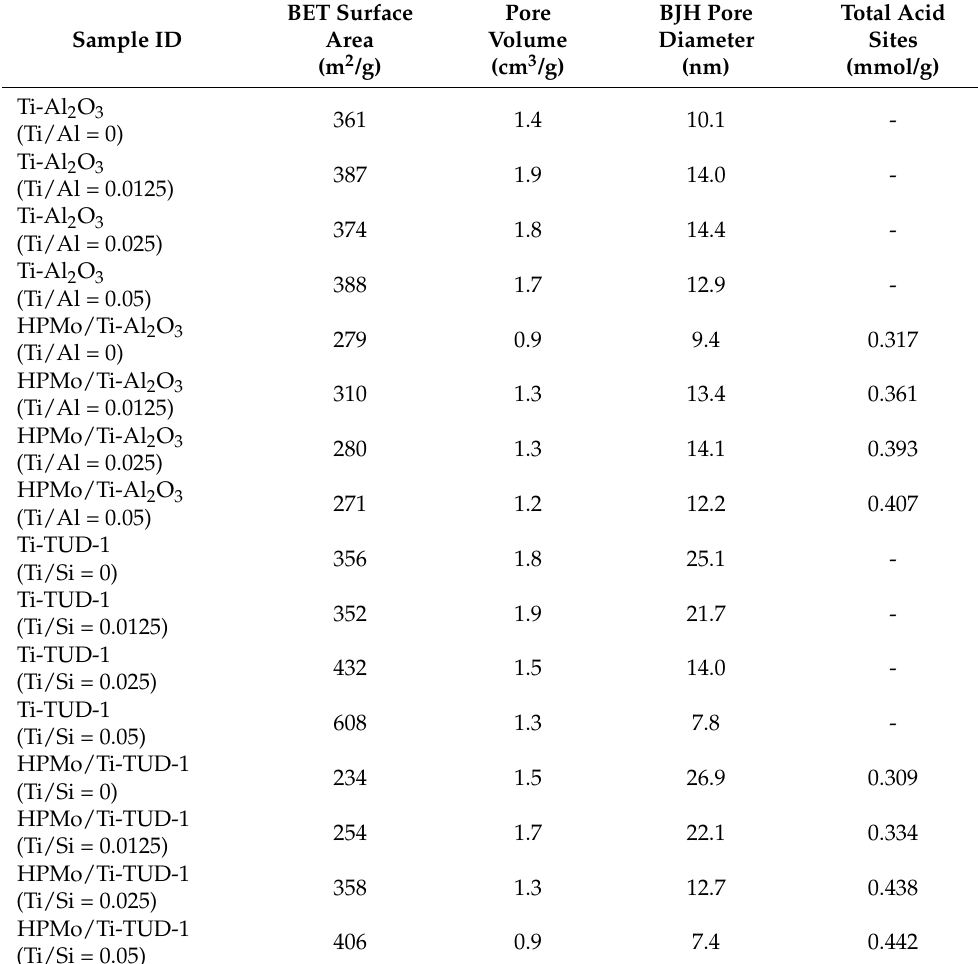
Figure 3. N 2 isotherm of ( a ) HPMo/Ti-Al 2 O 3 and ( b ) HPMo/Ti-TUD-1 catalysts.